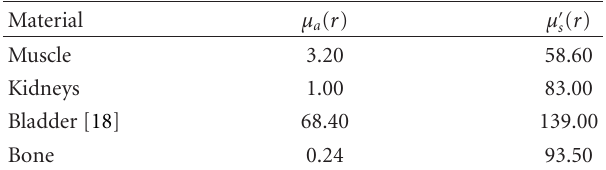
Table 1: Optical parameters of the nude mouse [17], 10 − 2 mm − 1 .